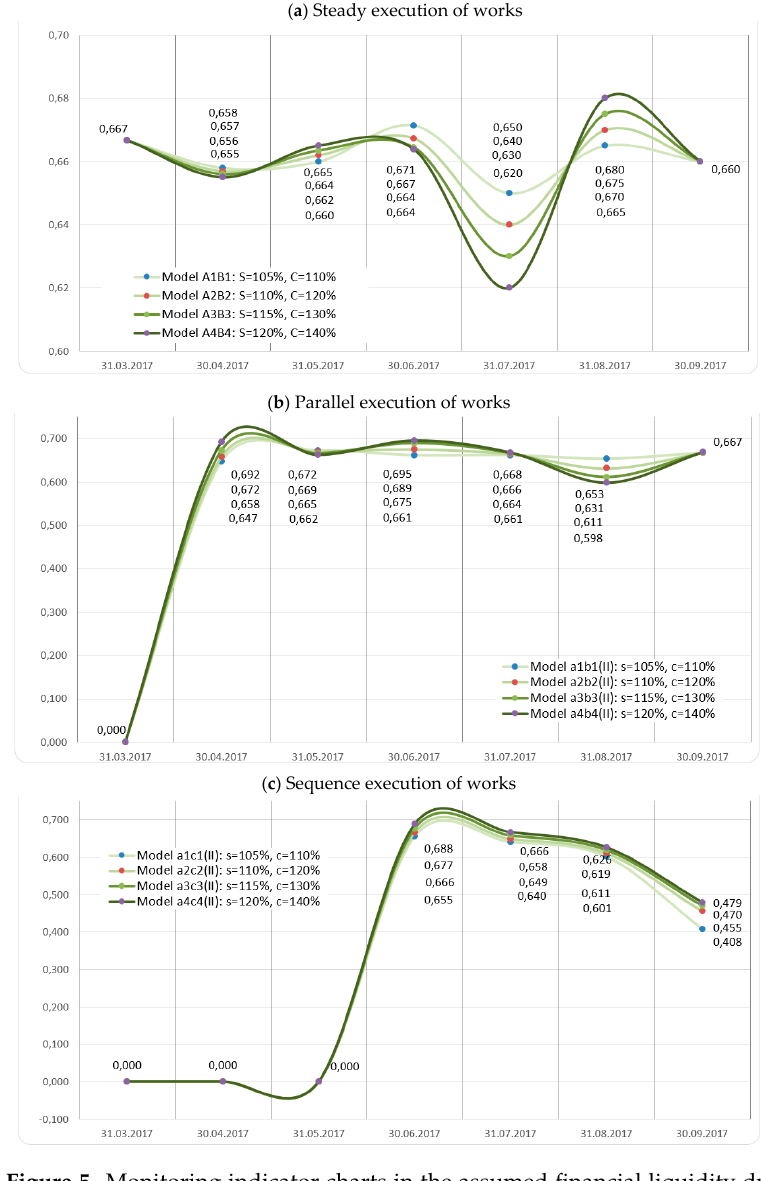
Figure 5. Monitoring indicator charts in the assumed financial liquidity due to arising variances from planned costs (T/C) in models with a gradually increasing time and cost variance-in the implementation methods according to (from above): steady, parallel, sequence execution of works. Source: [19].